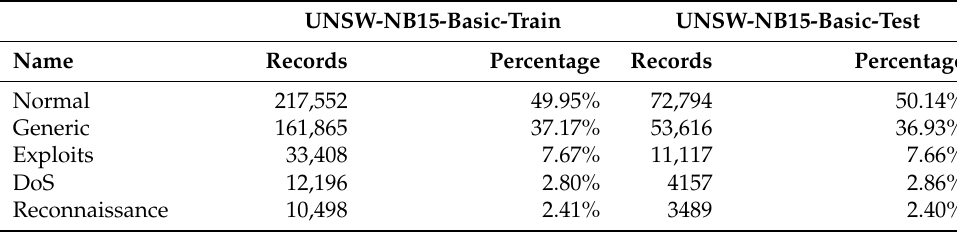
Table 4. UNSW-NB15-Basic-Train and UNSW-NB15-Basic-Test datasets.